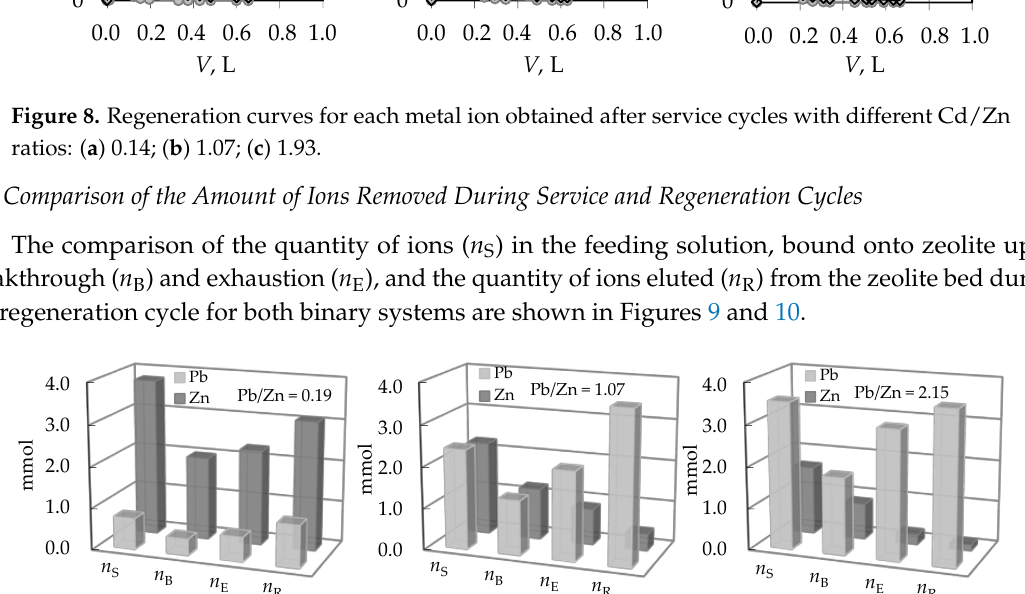
Figure 9. Comparison of n S , n B , n E , and n R for different Pb/Zn ratios in the feeding (Pb + Zn) solution.